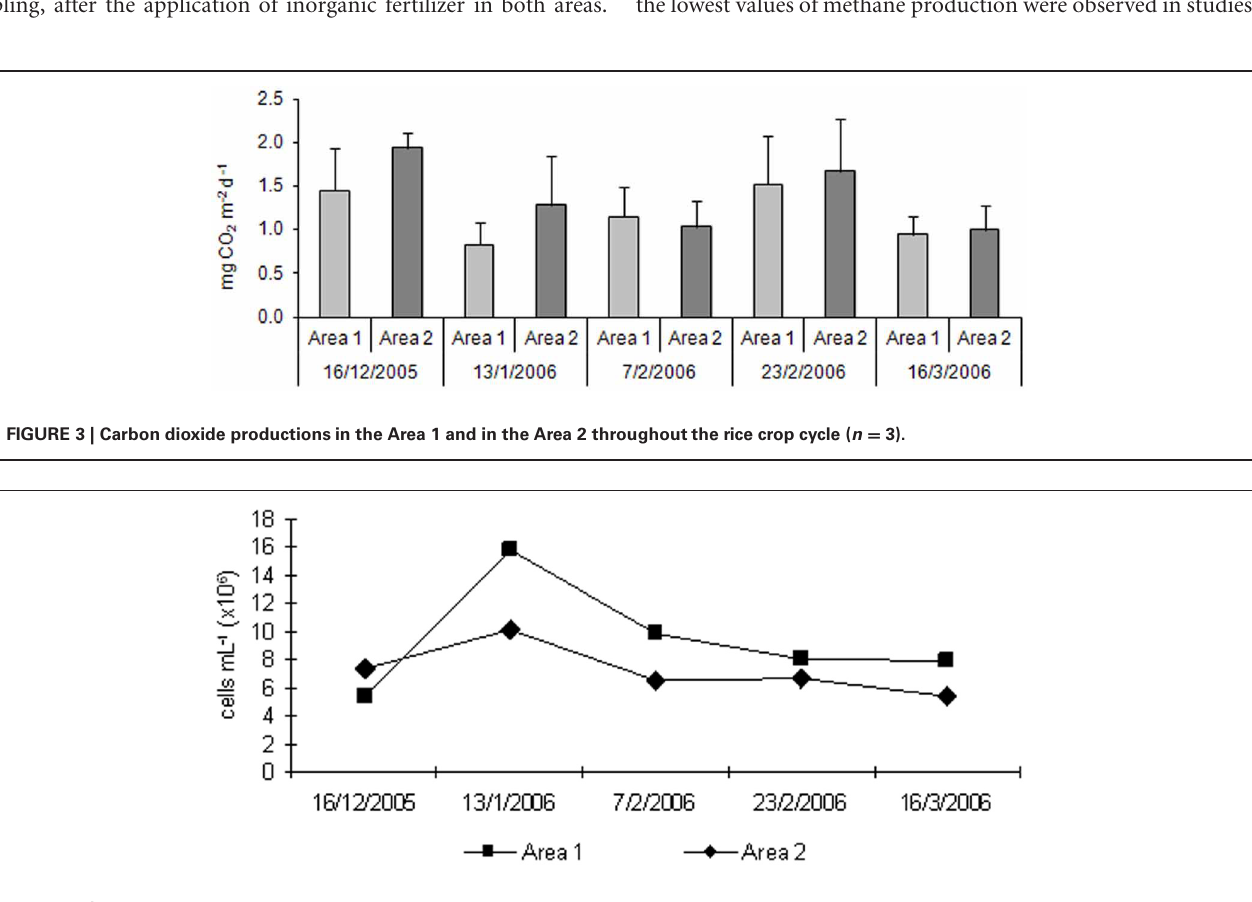
FIGURE 4 | Bacterioplankton abundance rates obtained from the water/sediment interface in both areas during rice cultivation.